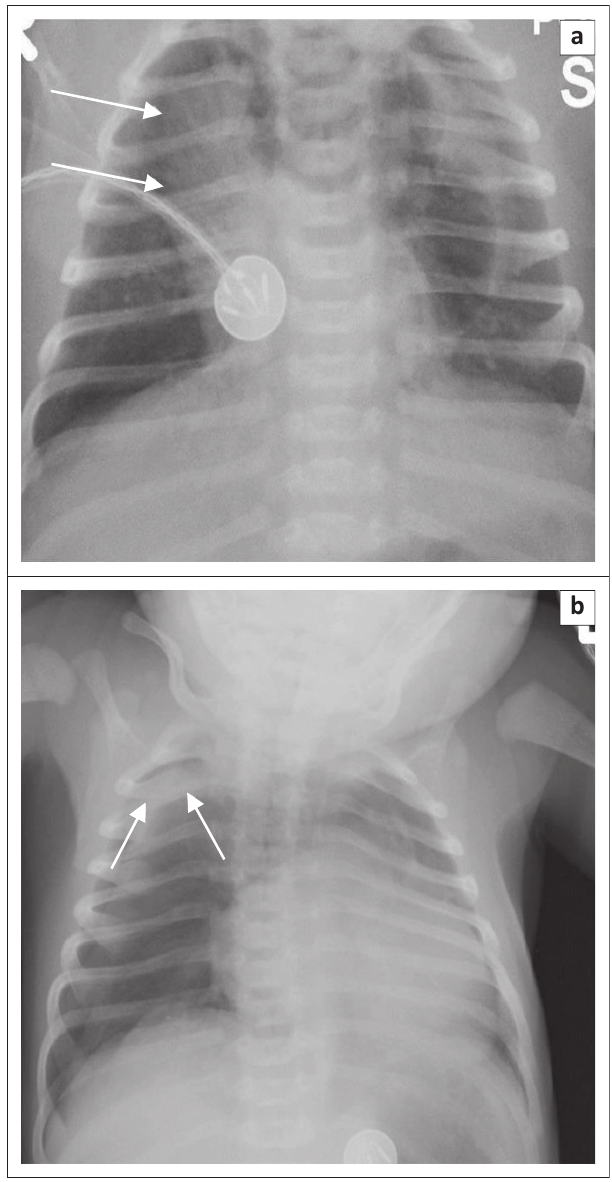
FIGURE 9: Patients with a left-sided tension pneumothorax. The thymus is displaced to the right (arrow) simulating a mediastinal mass (a). In another patient (b) with a pneumothorax, the thymus is displaced superiorly (arrows), appearing as an apical pleural